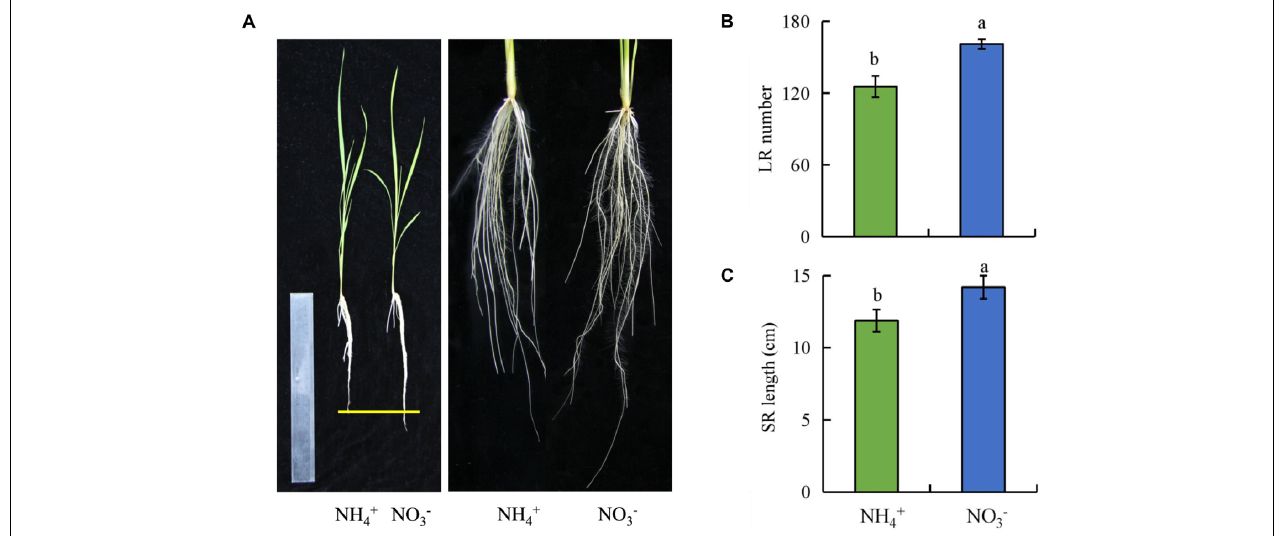
FIGURE 1 | The lateral root (LR) number and seminal root (SR) length in wild-type (Nipponbare) rice seedlings. Seedlings were grown in hydroponic media containing NH 4 + and NO 3 − for 14 days. (A) , The morphology of the rice plants; (B) , LR number; (C) , SR length. Data are means ± SE and bars with different letters indicate significant difference at P < 0.05 tested with ANOVA.